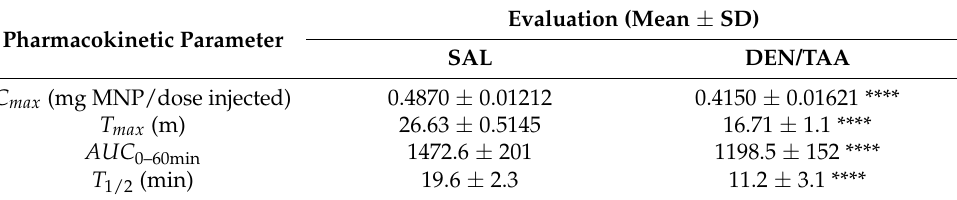
Table 1. Pharmacokinetic parameters of Cit-MnFe 2 O 4 MNPs after intravenous administration at a 32 mg/kg dose for the SAL and DEN/TAA groups. C max = the highest MNP level detected; T max = the time to the highest MNP level; AUC = the area under the curve; T 1/2 = half-life. **** p < 0.0001.